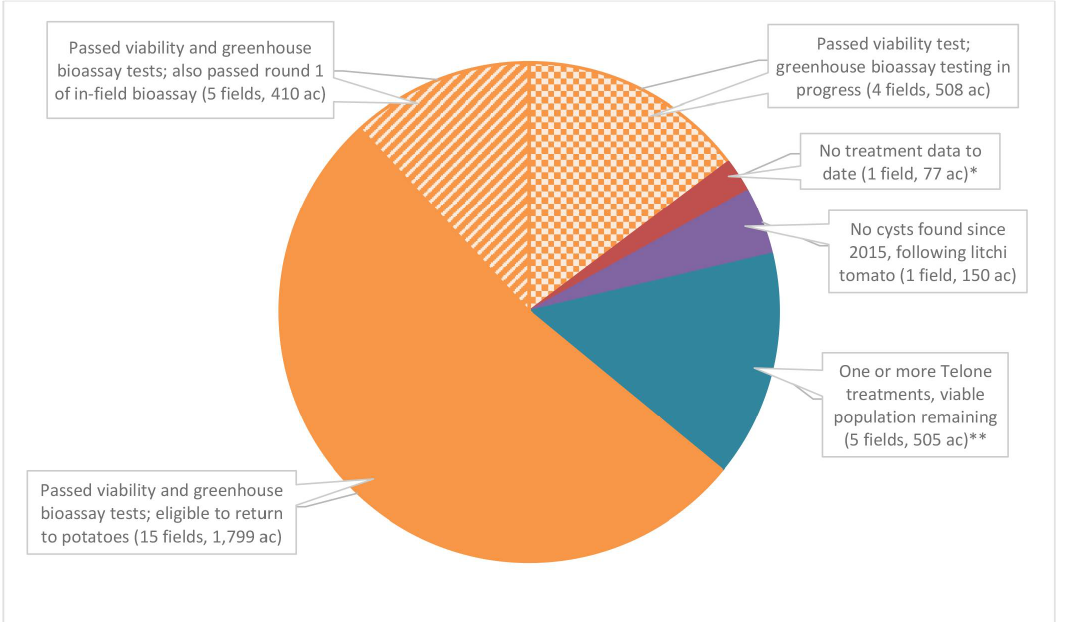
Figure 4. Progress for the 31 infested fields with Globodera pallida from Idaho (source, USDA, APHIS). * Field planted with a multi-year alfalfa crop in 2020; ** 2020 data; 2021 post-Telone data will be available by March 2022. This pie slice includes three fields that returned to potato production as part of the in-field bioassay test but viable nematodes were found in post-harvest